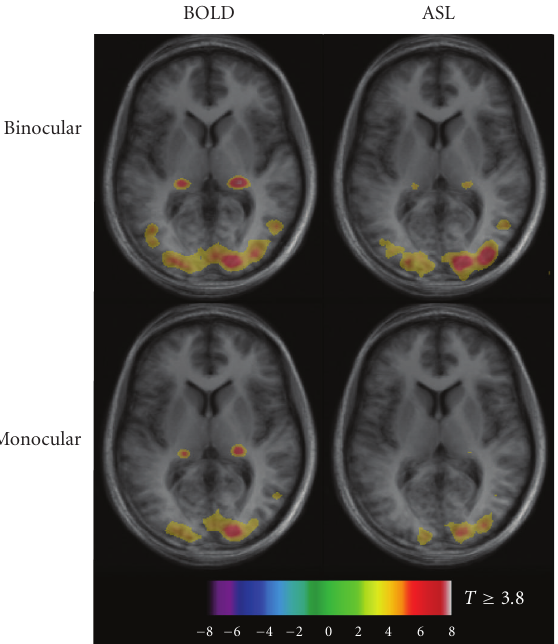
Figure 1: Mixed-e ff ects response maps for BOLD and flow changes in response to monocular and binocular visual stimulation (n = 6). Spatial extent and intensity are greater for binocular stimulation than for monocular, for both BOLD and flow signals. Thresholded activation maps are overlaid on average T1 maps for the six